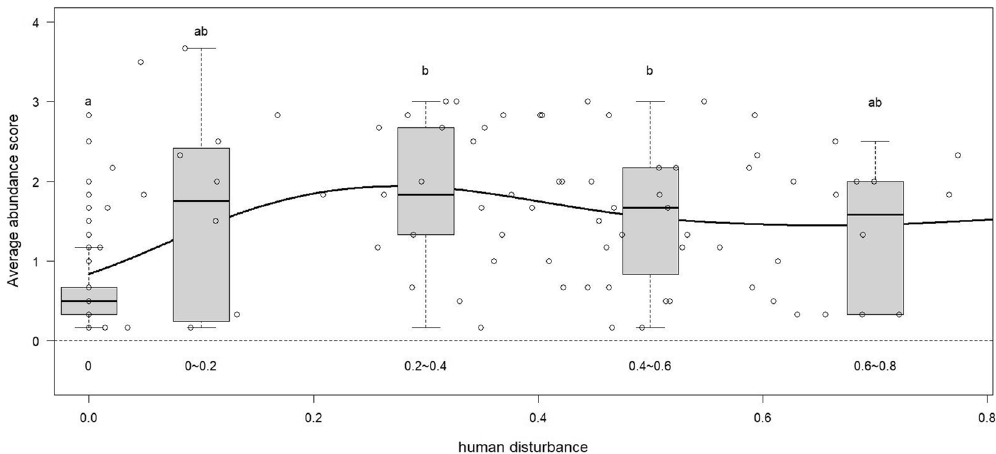
Figure 7. The average abundance score of Anoplolepis gracilipes in relation to the human disturbance level. The regression line was estimated by generalized additive models with Poisson error. Box plots labelled with different letters indicate statistical difference ( P < 0.05) between different categories of human disturbance (Wilcoxon rank sum test).